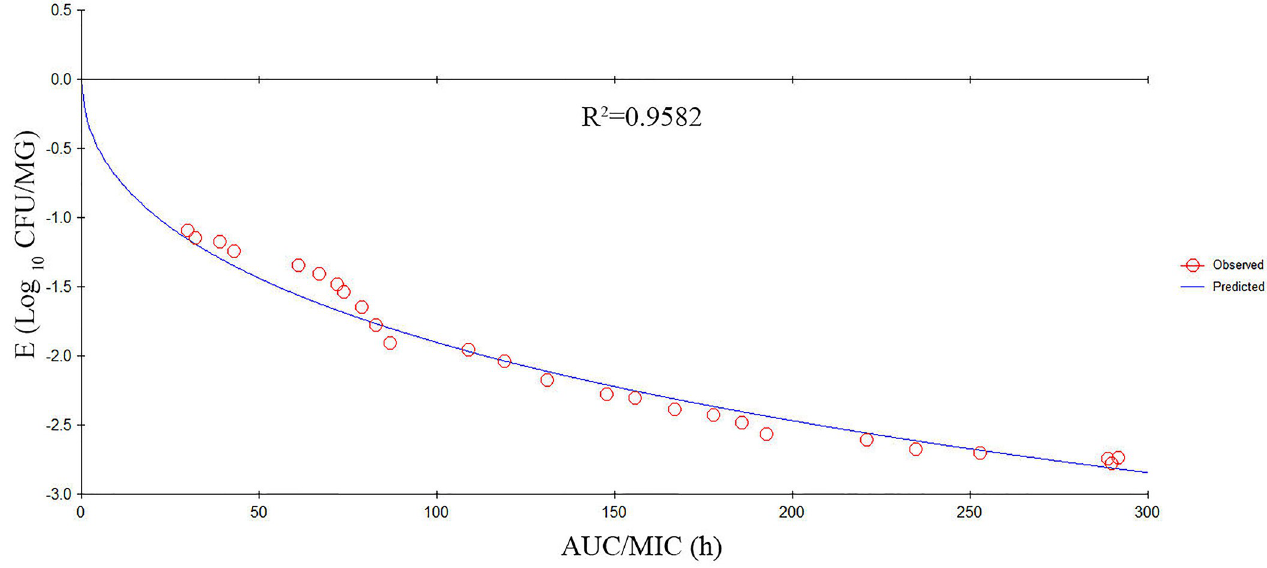
Fig 6. The inhibitory Sigmoid E max relationship between in vivo antibacterial effects ( 4 log CFU/MG) and the PK/PD index of AUC/MIC against S . agalactiae 3–64. The line represents the fit of the model to the data. The circles represent the observed PD data. R 2 indicates the correlation coefficient.